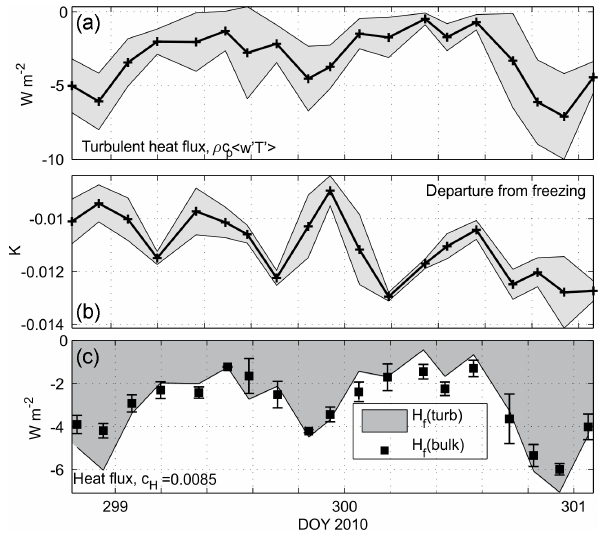
Figure 6. (a) Three-hour averages of turbulent heat flux, solid with standard deviation shading. (b) Departure of temperature from in situ freezing point temperature. (c) Comparison showing measured heat flux (shaded) with bulk estimates based on the product of u ∗ and (cid:49)T using the transfer coefficient identified using Eq.